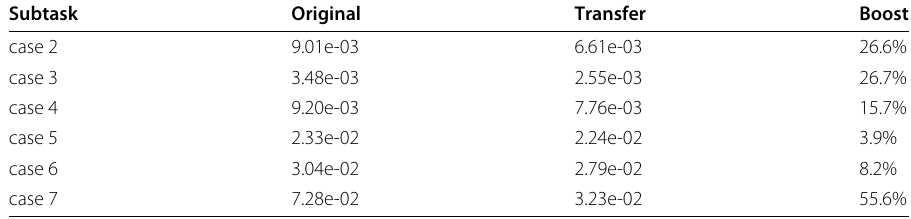
Table 3 Performance boost of GP-PINN on the Helmholtz benchmarks using transfer learning Subtask